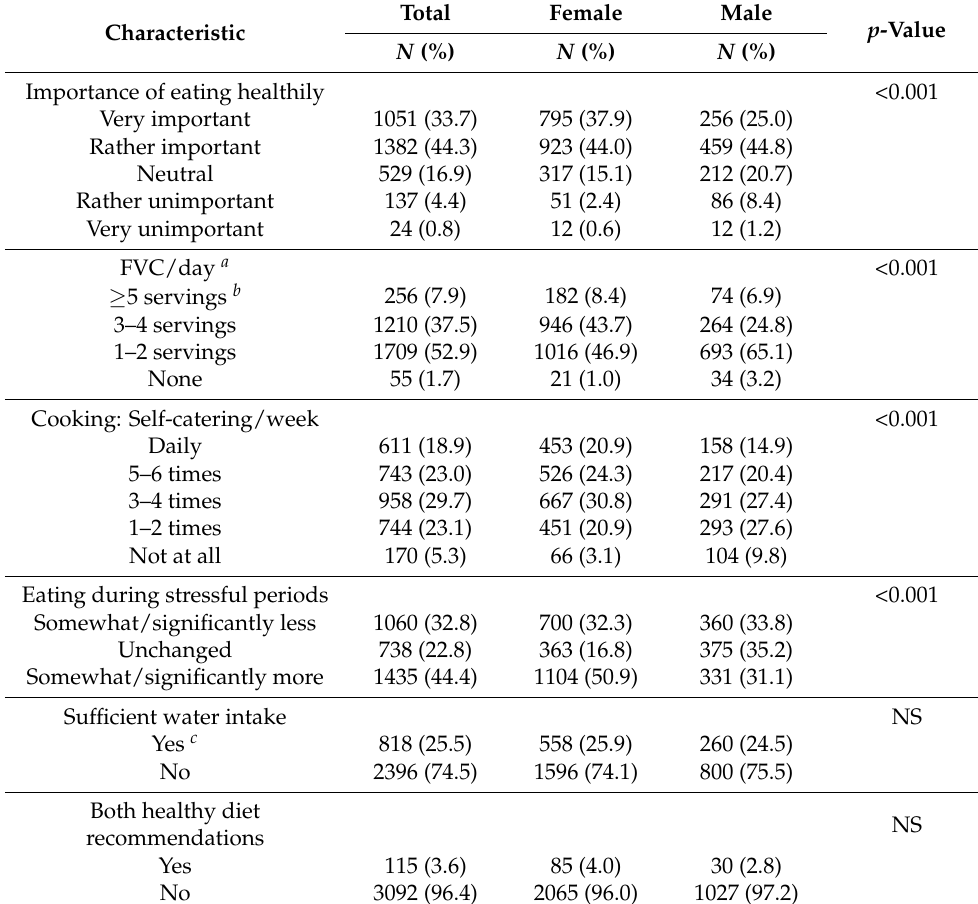
Table 3. Student nutritional behavior by